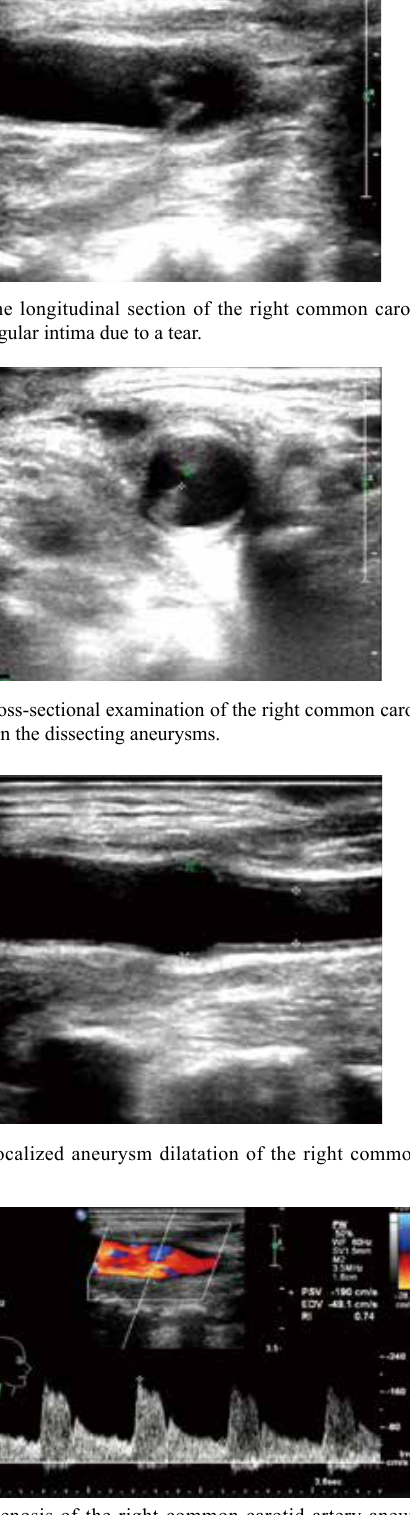
Figure 4 Stenosis of the right common carotid artery aneurysm and increased flow rate.